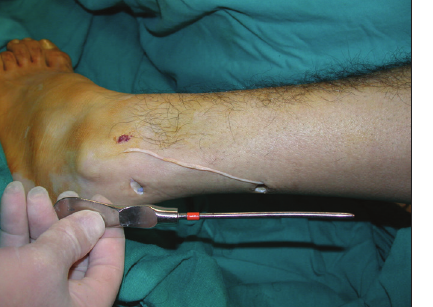
Figure 2. The sural nerve segment underneath the skin was fully and circumferentially released using the carpal tunnel dilators.